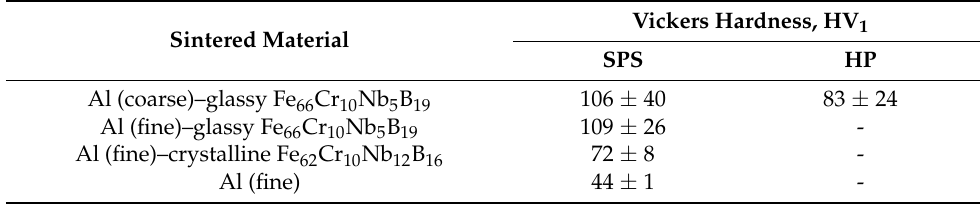
Table 2. Vickers hardness of the sintered composites and unreinforced aluminum. Sintered